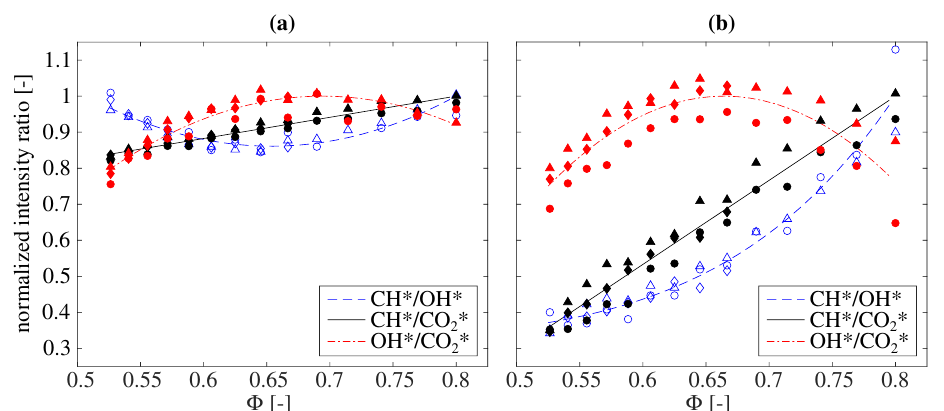
Figure 3. The dependence of different normalized chemiluminescence ratios on the equivalence ratio Φ for the combustion of natural gas under atmospheric conditions. The intensities of CH* and OH* are uncorrected in ( a ) and background corrected in ( b ). Various thermal powers are marked with symbols (diamond: 40kW, circle: 50kW, and triangle: 60kW).